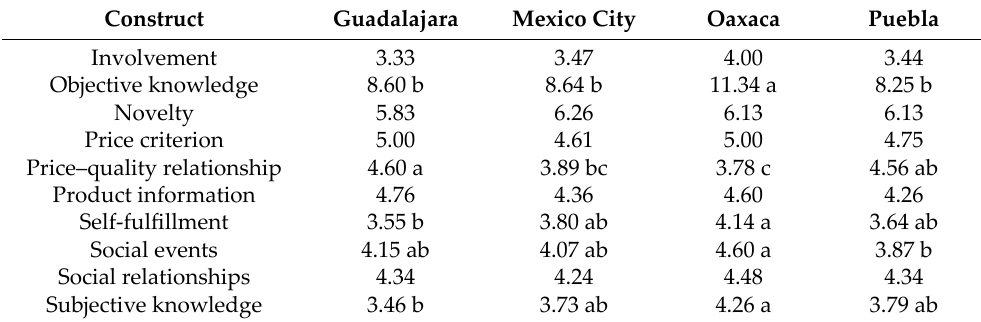
Table 3. ANOVA of constructs among the